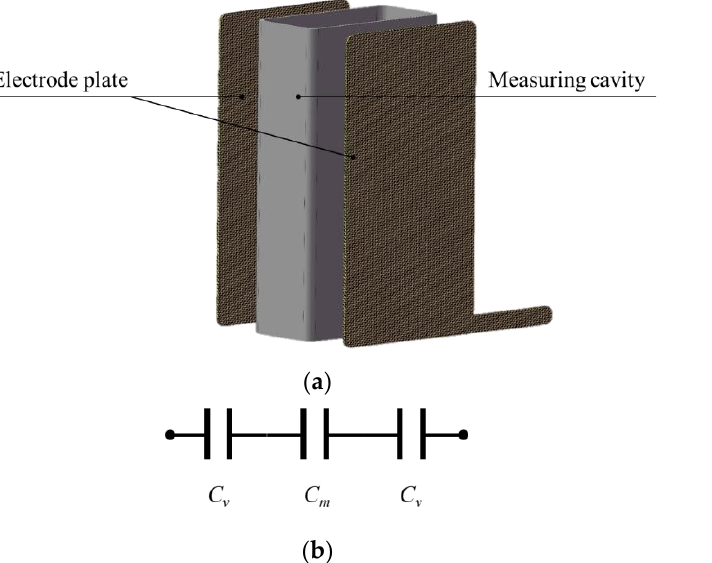
Figure 1. Model of a parallel plate capacitor sensor: ( a ) the original model and ( b ) the equivalent model.